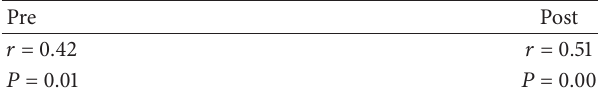
Table 4: Correlation